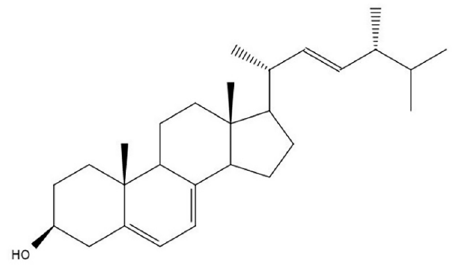
Figure 1. Structure of ergosterol.